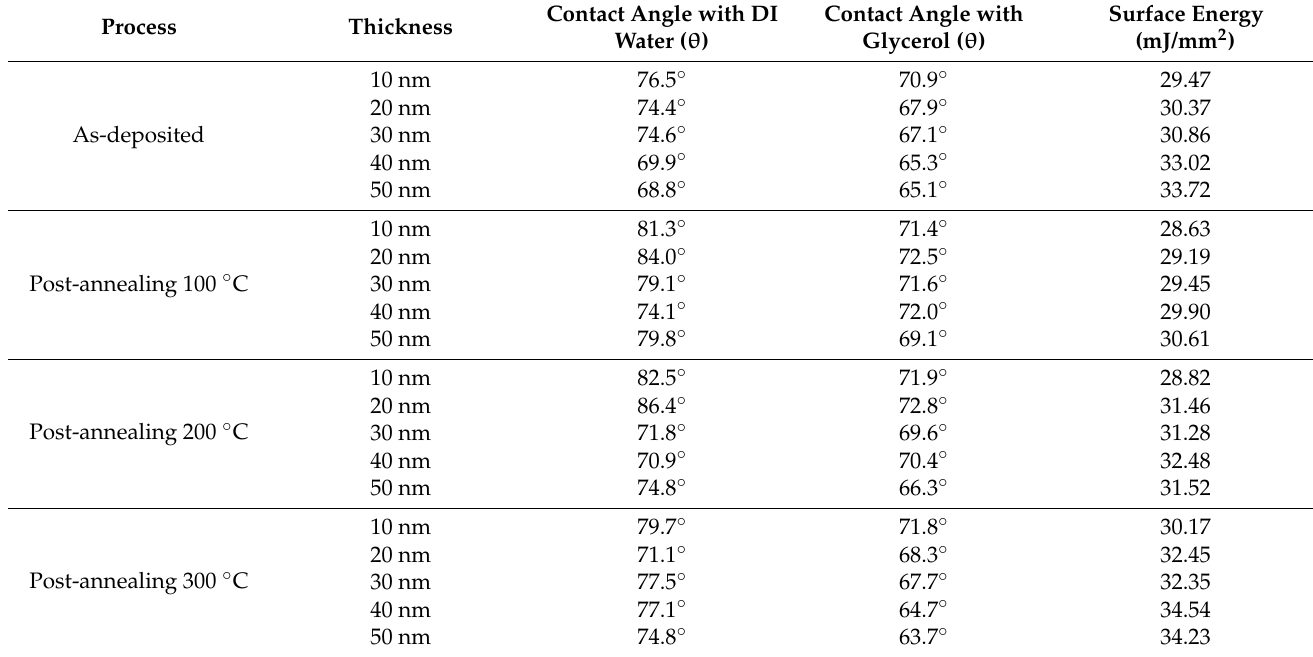
Table 3. Comparing contact angle and surface energy for Co 40 Fe 40 Yb 20 thin films from different fabrication